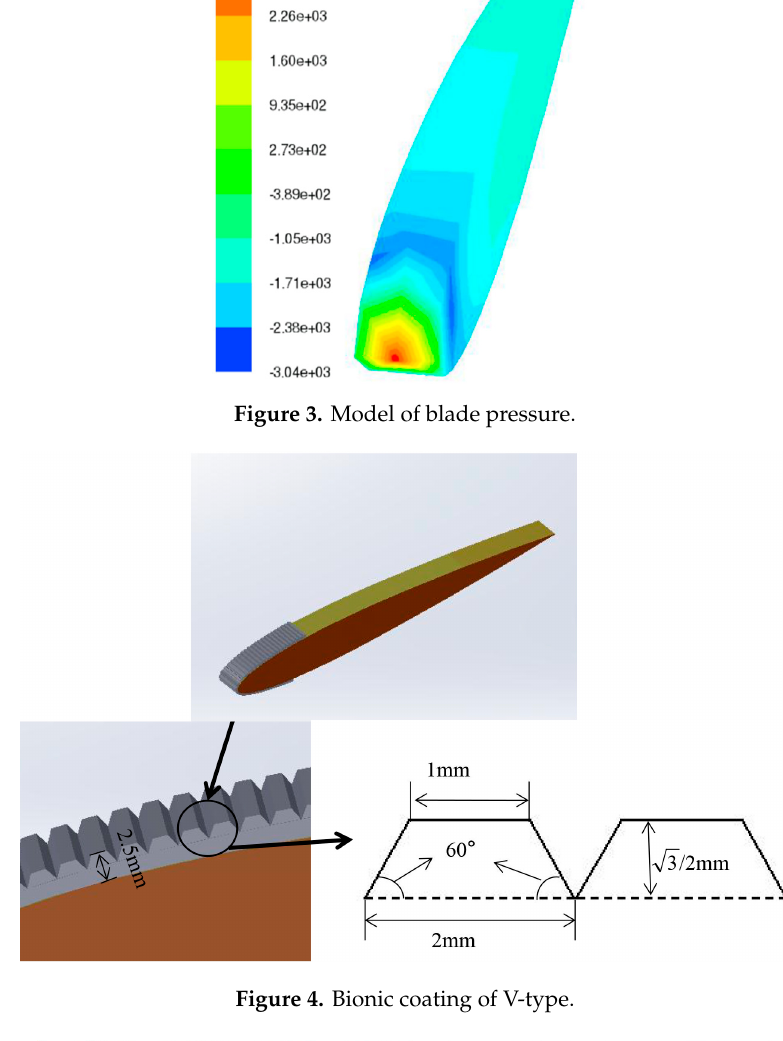
Figure 3. Model of blade pressure.